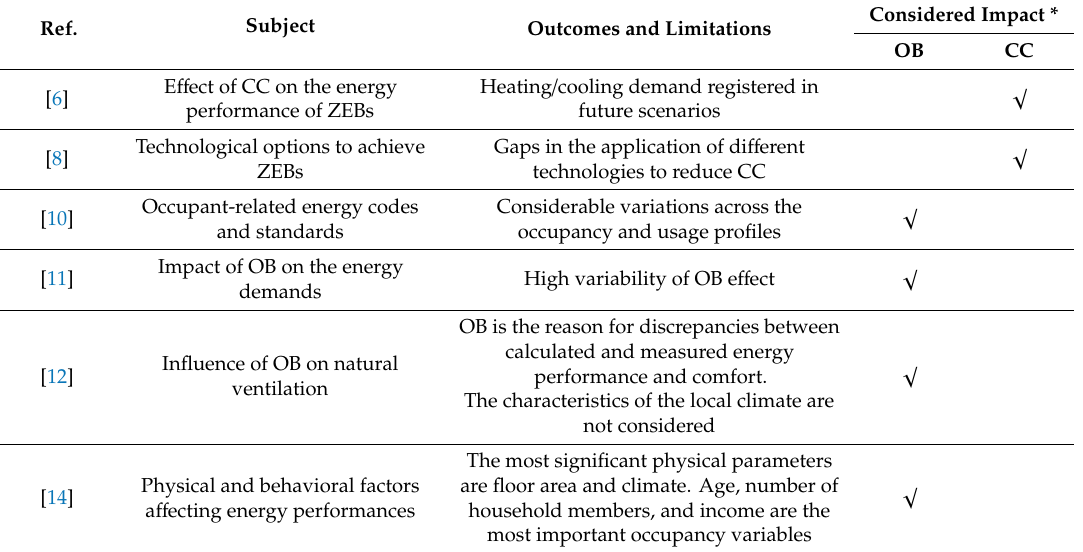
Table 1. Comparison of the Literature